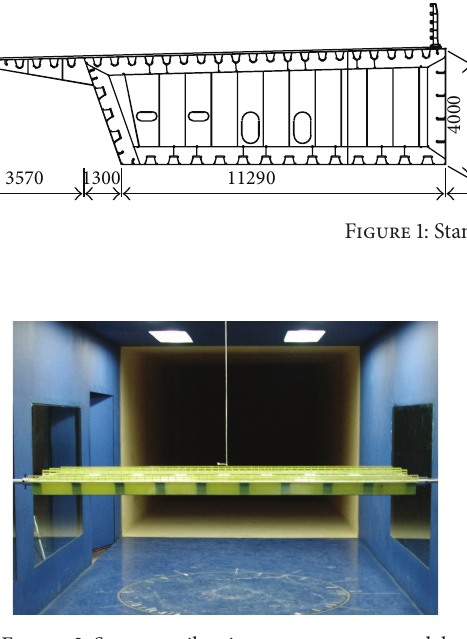
Figure 2: Segment vibration measurement model.